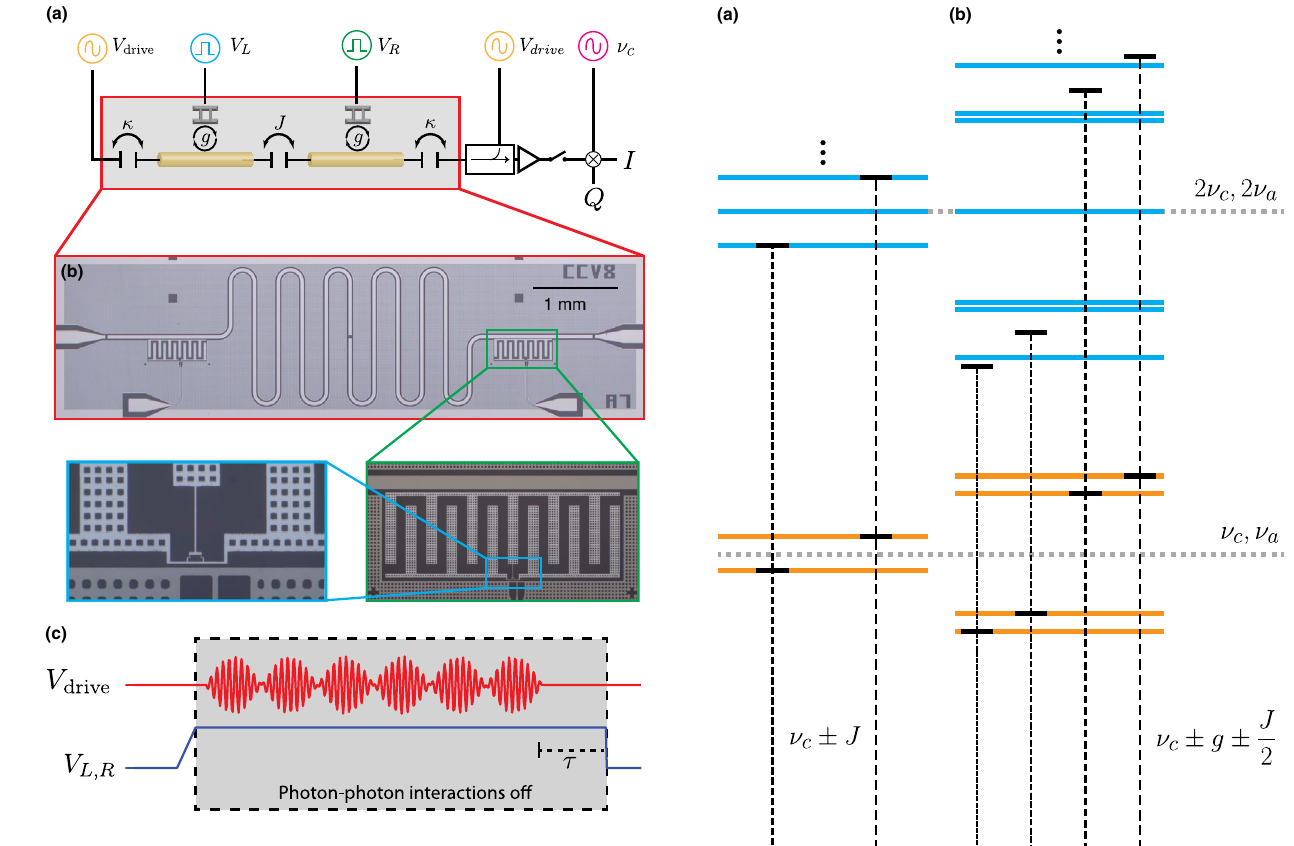
FIG. 3. Device layout and initialization routine. (a) Schematic diagram of the experiment. The Jaynes-Cummings dimer is composed of two coupled transmission-line resonators each FIG. 4. Low-lying dimer spectra and nonlinearities. Spectra are individually coupled to a transmon qubit. Intercavity coupling shown for the two flux bias points in the experiment, without J ¼ 8 . 7 MHz and cavity-qubit coupling g ¼ 190 MHz. The (a) and with (b) photon-photon interactions. The first (orange) and resonators are driven and monitored via coupling to external second (blue) excitation manifolds are shown along with tran- transmission lines. Initialization pulse V can be applied to the drive sitions (black), where transitions from the first to second excitation left or right cavity to generate classical oscillations in the system, manifold are the same frequency as the ground to first transitions while fast flux pulses V control qubit energies at nanosecond L;R immediately below. (a) Effective photon-photon interactions can time scales. Right cavity quadratures are monitored via a be turned off by tuning qubits to their minimum energies. While homodyne measurement. When V is applied to the right drive detuned, the qubits remain in their ground states and can be cavity, a fast microwave switch is used to block the strong ignored, resulting in a simplified spectrum of two cavities in reflected signal. (b) Optical micrograph of the device. (c) Initial- resonance. The J coupling creates two linear hybridized modes ization routine pulse waveforms. Fast flux pulses V rapidly L;R (cid:2) J , ideal for generating full linear oscillations with energies ν detune both qubits to their minimum energies to turn off c [ Z ð t Þ oscillates between (cid:2) 1 ]. Modulating V at J generates photon-photon interactions. While qubits are detuned, either drive ¼ sidebands resonant with each mode and explicitly sets the phase of the left or right cavity is driven with initialization pulse V drive theresultantlinear oscillations, generating animbalancedcoherent t Þ sin ð 2 π Jt Þ Θ ð − t Þ Θ ð t þ m=J Þ , where m is an integer sin ð 2 πν c state at t ¼ 0 . (b) Photon-photon interactions are generated by and Θ is the Heaviside step function. Variable delay τ after the tuning both qubits into resonance with the cavities. At this bias end of V allows the photon-photon interactions to be turned drive point, the first excitation manifold has four polariton states at on at any point during the undriven linear oscillations, enabling (cid:2) g (cid:2) J= 2 . Strong single-photon nonlinearities are energies ν the preparation of any desired imbalance. c apparent, as no transitions to the second manifold match the energies of the first manifold. Because of the form of the Jaynes- Cummings Hamiltonian, all nonlinearities are photon number dependent and lead to linear behavior at high excitation